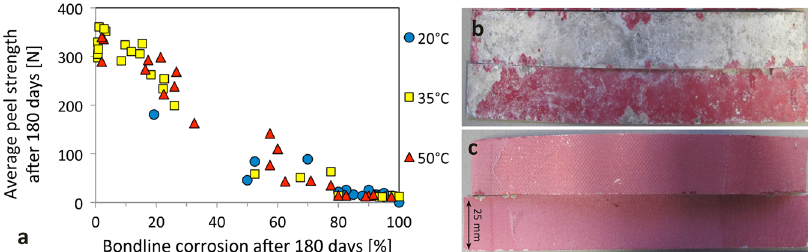
Fig. 4 a Left : Average peel strength after 180 days in the salt spray cabinet vs. the amount of bondline corrosion. Right : Characteristic images of the peeled panels that represented poor ( b ) and good adhesion ( c ). Oxide preparation conditions b SAA20 and SAA50